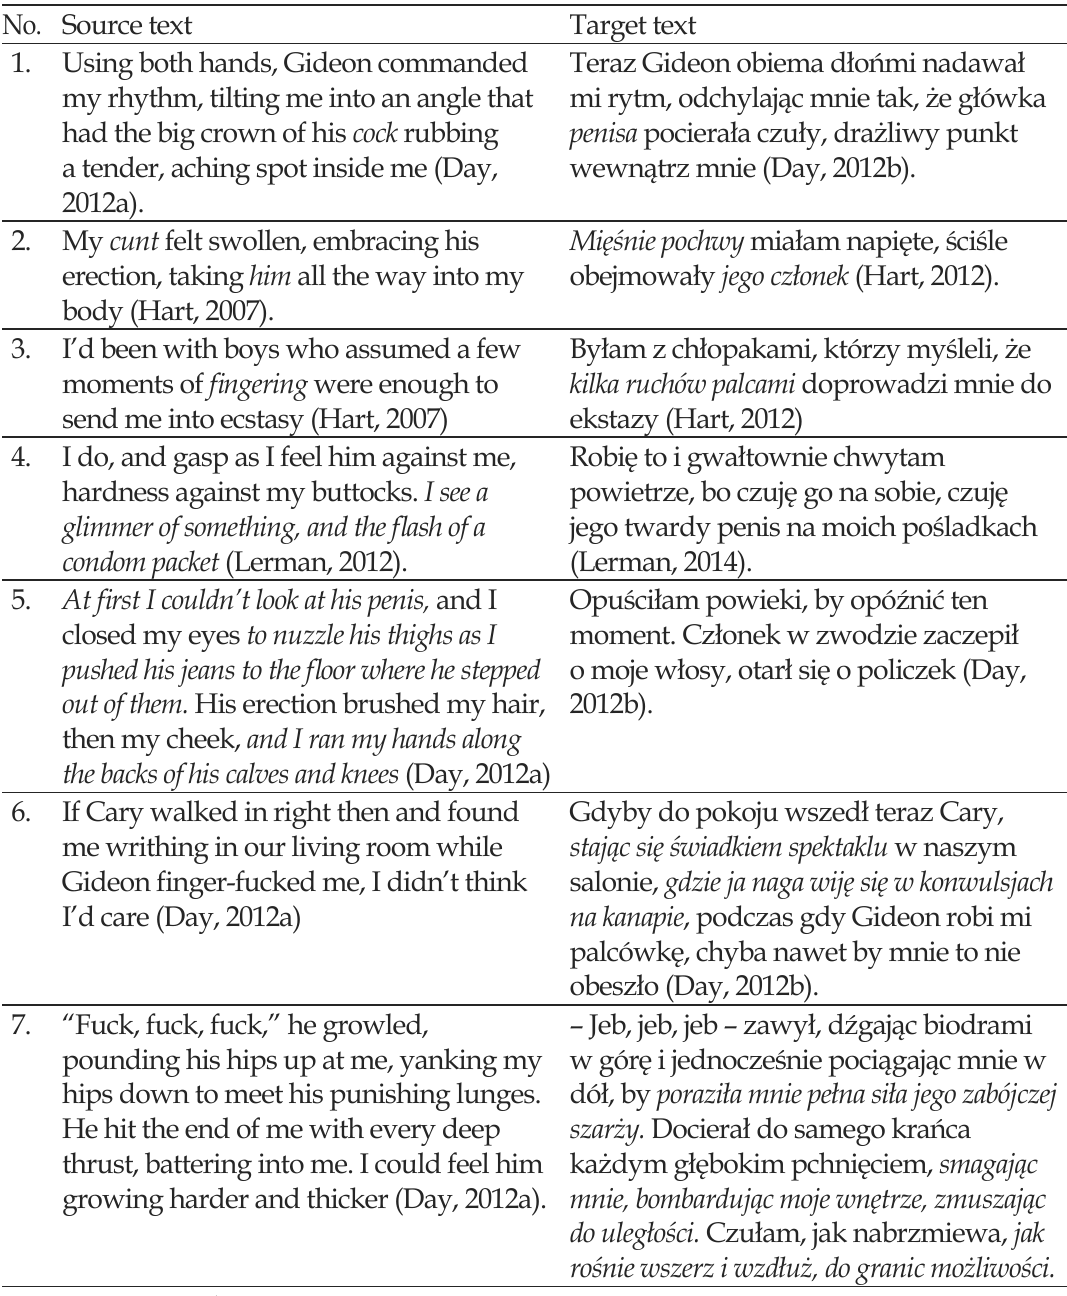
Paired couples of source and target texts presenting the issue of translation of sensitive and sex-related